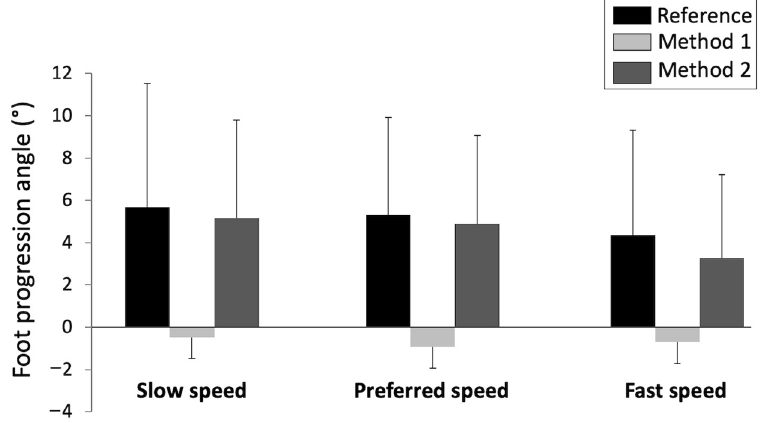
Figure 2. Means and standard deviations of foot progression angle obtained from the reference method and both force-plate methods in the three speed conditions.